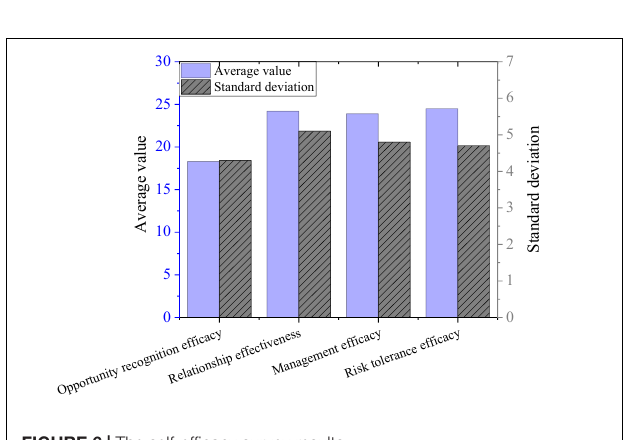
FIGURE 6 | The self-efficacy survey